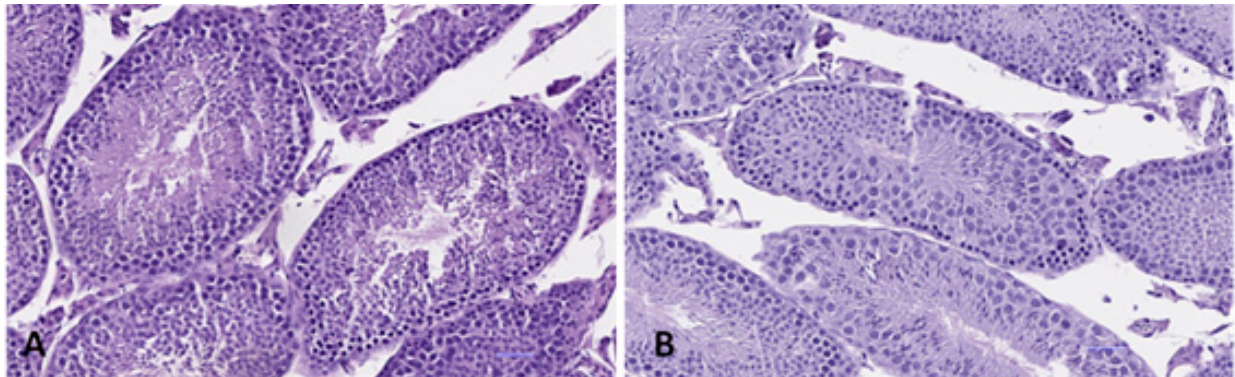
Figure 11. Histological sections of testis in male mice in the control group ( A ) 8.5× and group G5 ( B ), (H-E 14.5×).